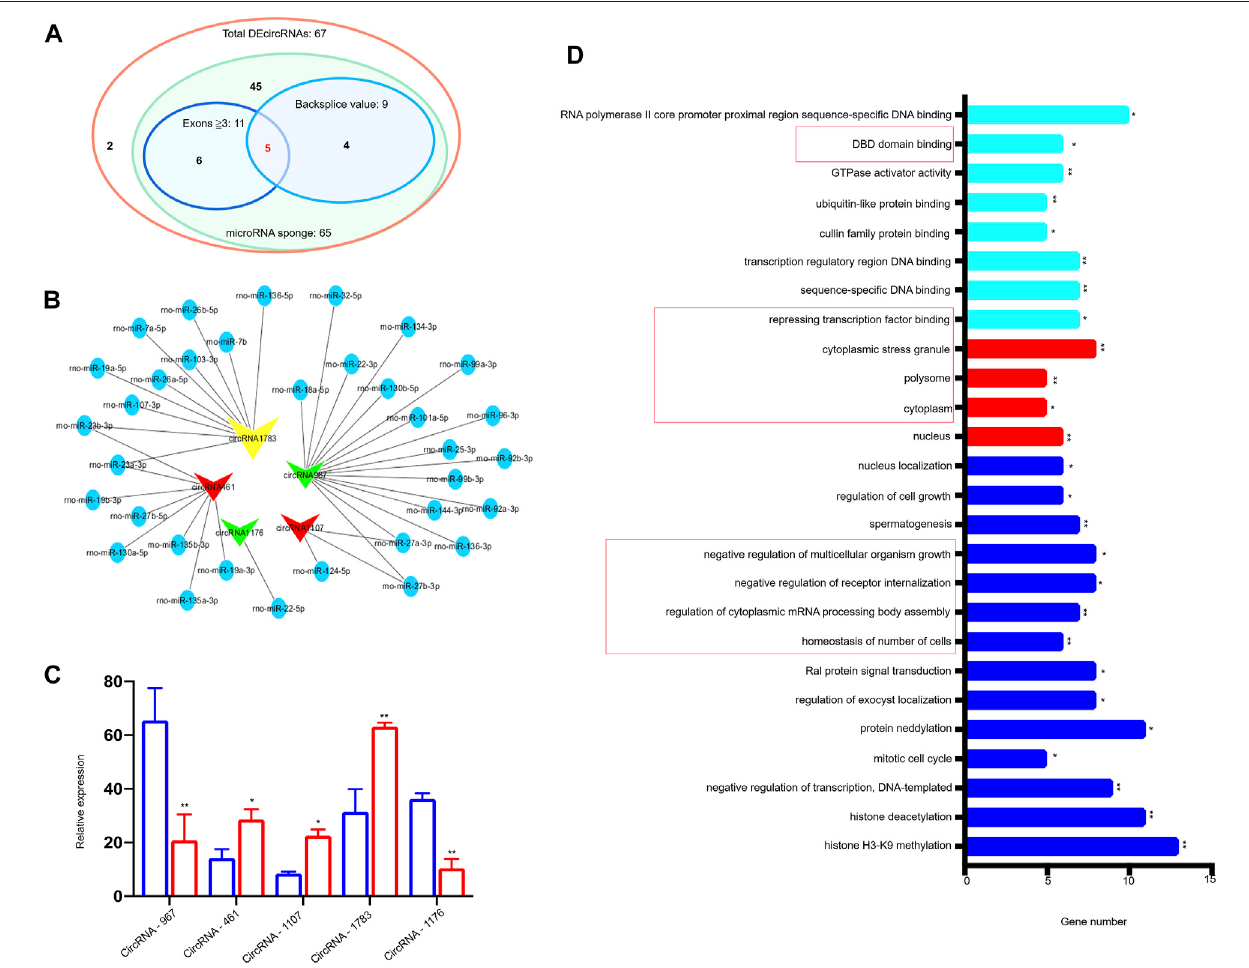
FIGURE 4 | Characterization of 5 DEcircRNAs in rat subcutaneous adipose tissue. (A) Venn show abundant (exons ≥ 3) exonic DEcircRNAs with potential miRNA binding sites and DEcircRNAs with backsplice value of every sample. (B) Bioinformatics prediction of 5 circRNAs, their predicted miRNAs, and miRNA targets. circRNAs were plotted as V-shapes. Yellow V-shapes represent circRNA-1783 (circ-ATXN2), which is an up-regulated circRNA. Green V-shapes represent down-regulated circRNAs (circRNA-967, circRNA-1176). Red V-shapes represent up-regulated circRNAs (circRNA-461, circRNA-1107). miRNAs were plotted as blue nodes. (C) Expression pattern of the 5 DEcircRNAs between young and old rat subcutaneous adipose tissue based on mRNA sequencing. * p < 0.05, ** p < 0.01 compared with young group. (D) GO analysis of the 5 DEcircRNAs. Using GO database (http://www.geneontology.org) analysis the GO enrichment of DEcircRNAs, based on three aspects: biological processes (BP, blue strip), cellular components (CC, red strip), and molecular functions (MF, sky blue strip). GO terms which in the red frame were related to the circRNA-1783 (circ-ATXN2). *represent the signi fi cance of the GO term enrichment among the 5 selected DEcircRNAs. * p < 0.05, ** p < 0.01 compared with young group. Expression was normalized to actin and expressed as mean ± SEM (n (cid:1) 3), by two-way